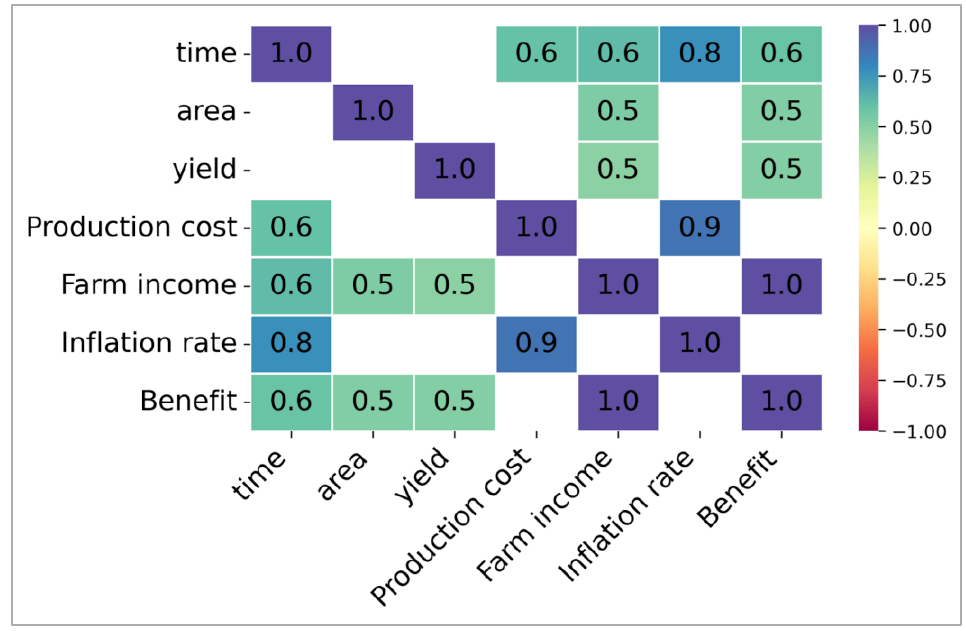
Figure 4. Pearson correlations between variables used in the Bayesian model. The variables represent the financial income and physical characteristics of the farm. Blank cells represent non-significant correlations at p -value < 0.05.